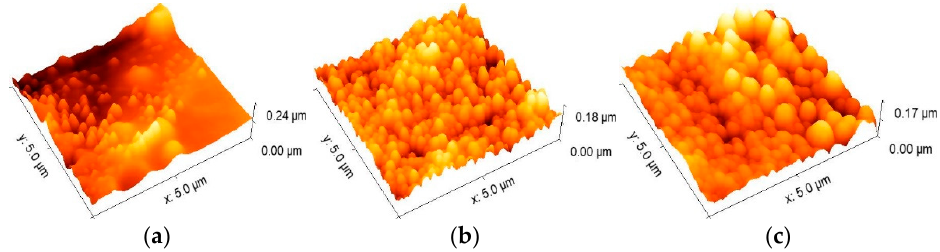
Figure 4. AFM image and 3D topology of the deposited CuO thin films, T s , K: ( a ) 625, ( b ) 675, ( c ) 725.